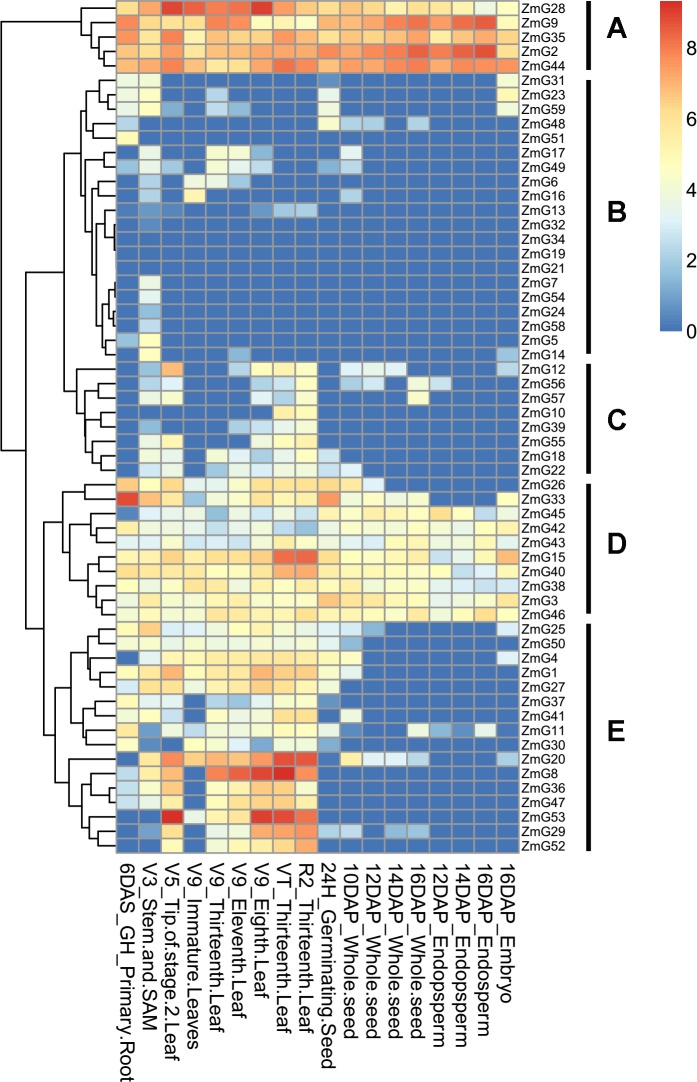
Heat map of maize G2-like genes.The expression level of each G2-like gene can be estimated based on the scale to the right. Red, yellow and blue indicate high, medium and low levels of gene expression, respectively. H, hours; DAS, days after sowing; GH, greenhouse; V, vegetative; DAP, days after pollination; VT, vegetative tasseling; R, reproductive.